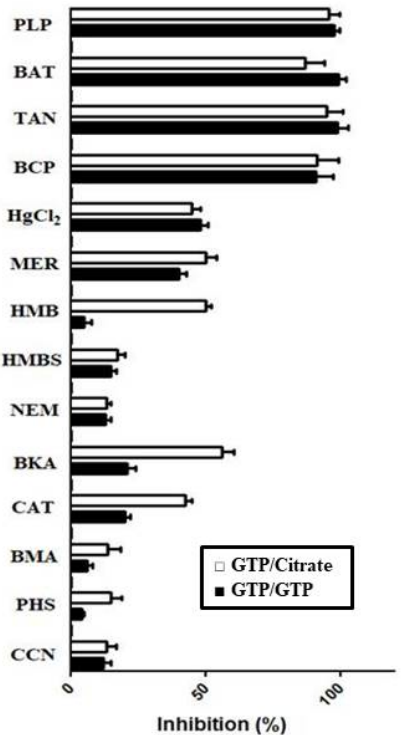
Figure 5. Effect of inhibitors on GTP/GTP exchange and citrate-induced GTP uptake by proteoli- posomes reconstituted with Ggc1p. Proteoliposomes were preloaded internally with 5 mM GTP (black columns) or 5 mM citrate (white columns). Transport was started by adding 1 µ M [8- 3 H] GTP and terminated after 20 s. All inhibitors were added together with [8- 3 H] GTP, but thiol reagents and α -cyanocinnamate were added 2 min before the labeled substrate. The final concen- trations of the inhibitors were 0.05% (TAN, tannic acid), 0.1 mM (HgCl 2 , mercury chloride; HMB, p-hydroxymercuribenzoate; HMBS, p-hydroxymercuribenzene sulfonate; BKA, bongkrekic acid and CAT, carboxyatractyloside), 0.3 mM (BCP, bromocresol purple), 1 mM (CCN, α -cyanocinnamate) and 2 mM (PLP, pyridoxal 5 (cid:48) -phosphate; BAT, bathophenanthroline; NEM, N-ethylmaleimide; BMA, butylmalonate; PHS,